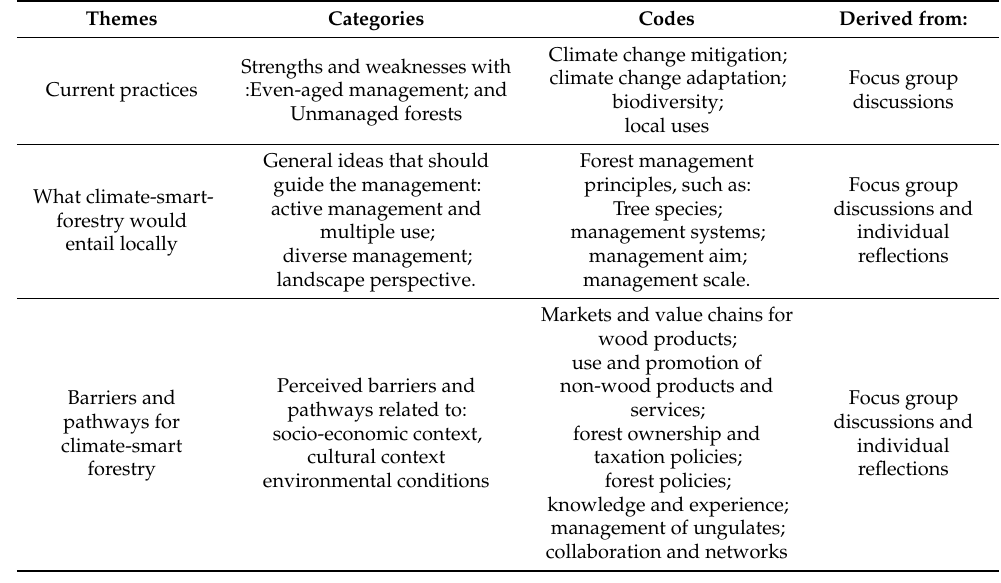
Table 2. The final themes, categories and codes derived from the